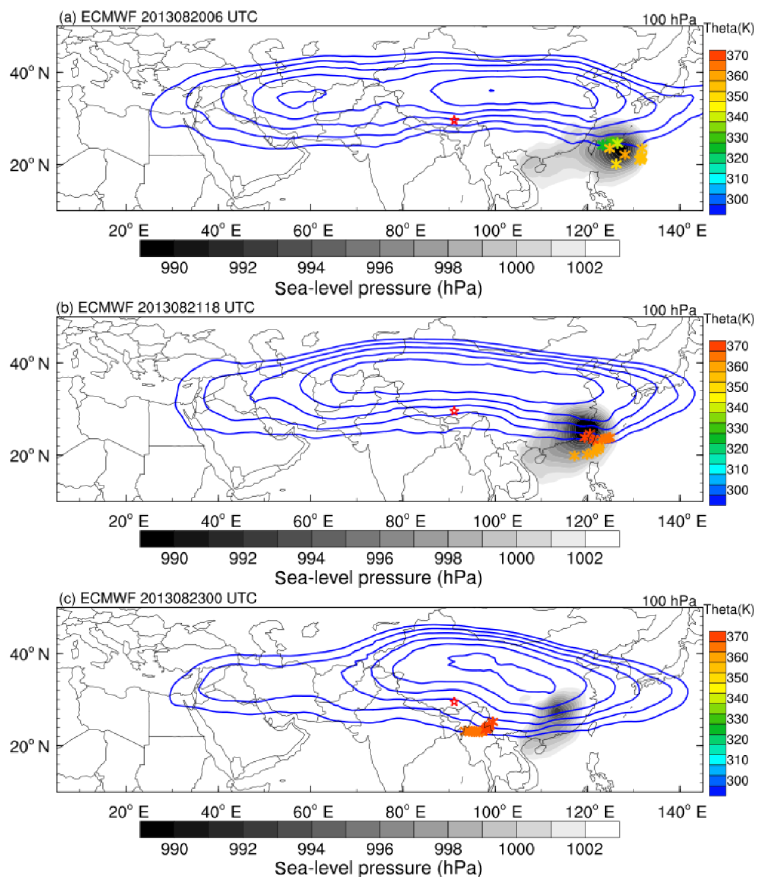
Figure 5. The geopotential height at 100hPa pressure level (blue contour lines, > 16.72km) and sea-level air pressure (shade, hPa) of Trami at (a) 06:00UTC 20 August, (b) 18:00UTC 21 August, and (c) 00:00UTC 23 August. The asterisks, colour-coded by potential temperature, mark the geographical positions of target parcels. The red star marks the location of